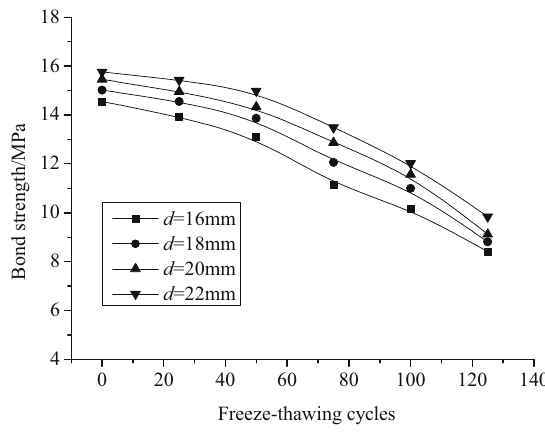
Figure 3: Bond strength of the RAC specimen with di ff erent steel bar